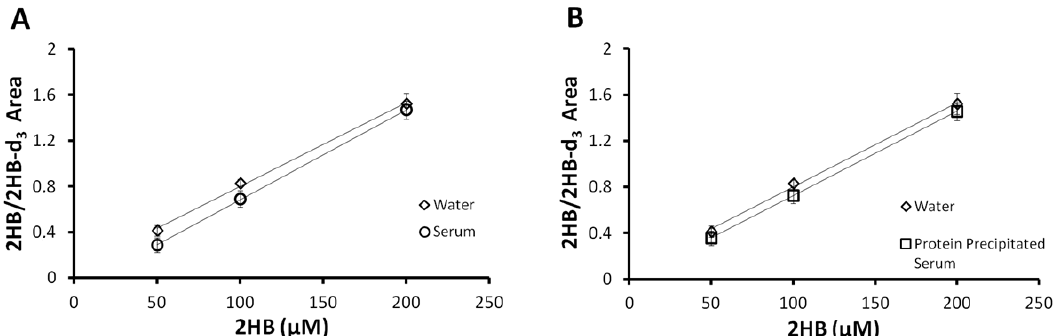
Figure 1. Matrix effect evaluation. ( A ) Three-point curves spiked in human serum compared with the respective curves spiked in water; ( B ) three-point curves spiked in protein precipitated human serum compared with the respective curves spiked in water.